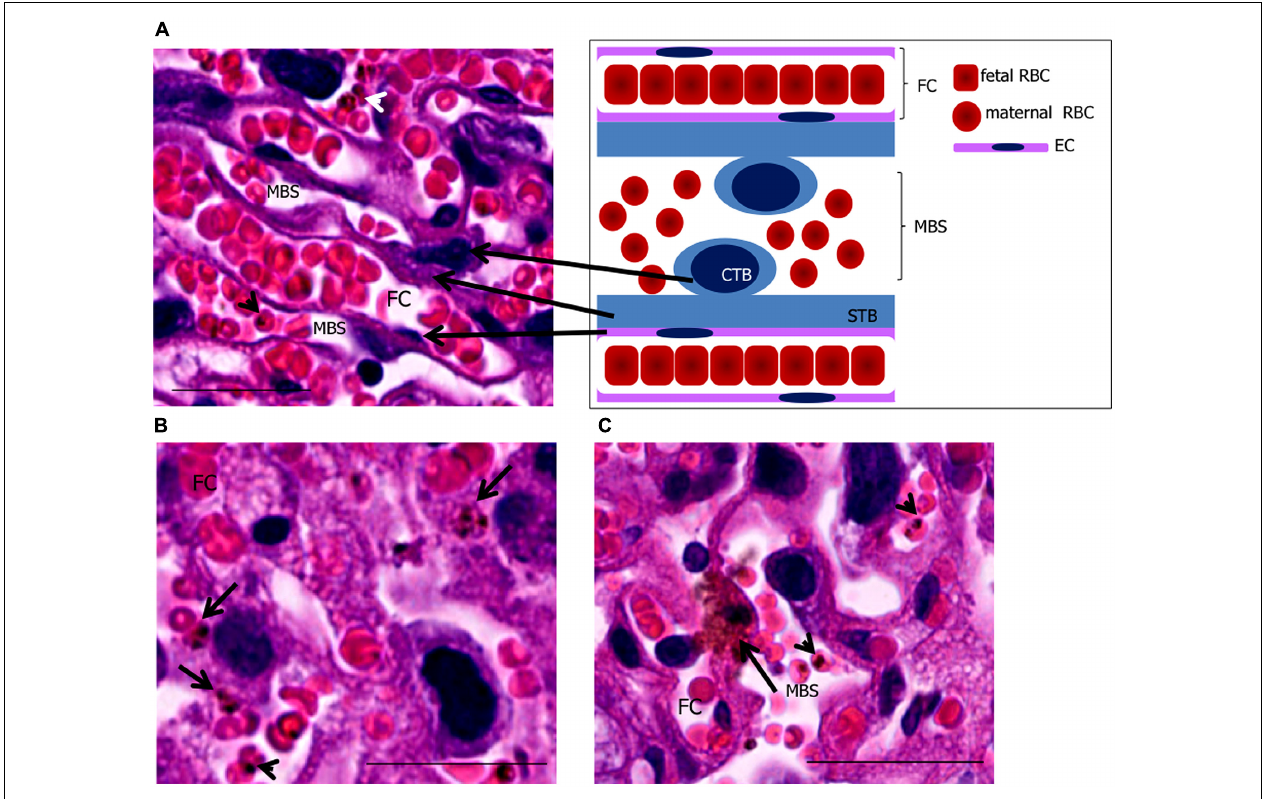
FIGURE 1 | Phagocytosis by trophoblasts of infected mouse placentas at end-stage gestation. (A) placental histology showing trophoblasts [cytotrophoblasts (CTB) and syncythiotrophoblasts (STB)], maternal blood space (MBS), endothelial cell (EC), and fetal